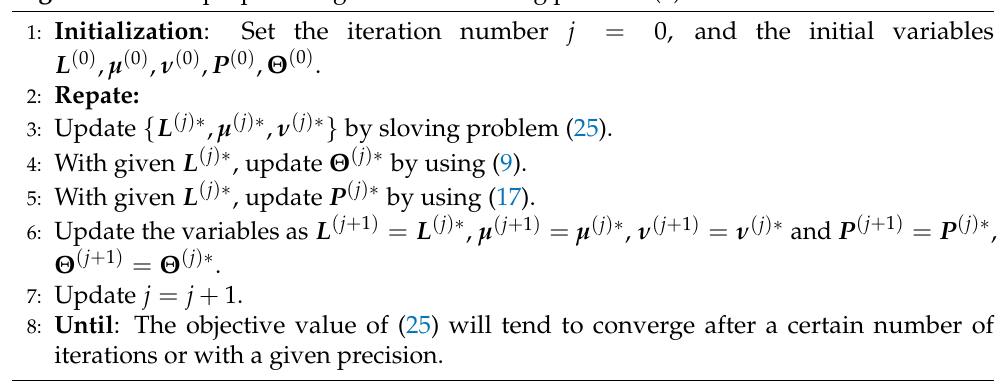
Algorithm 1 The proposed algorithm for solving problem